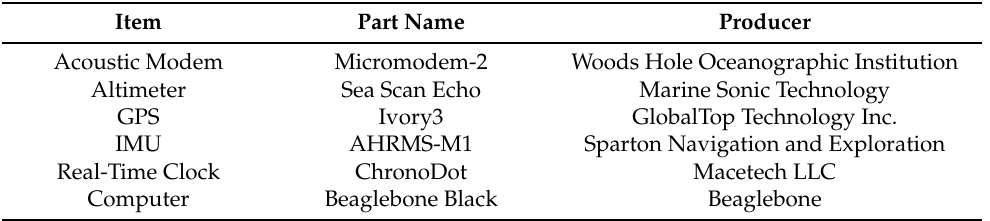
Figure 3. Riptide Autonomous Solutions micro-unmanned underwater vehicles (uUUVs) used for the experiments on Foster Reservoir, OR. Table 1. Relevant Riptide